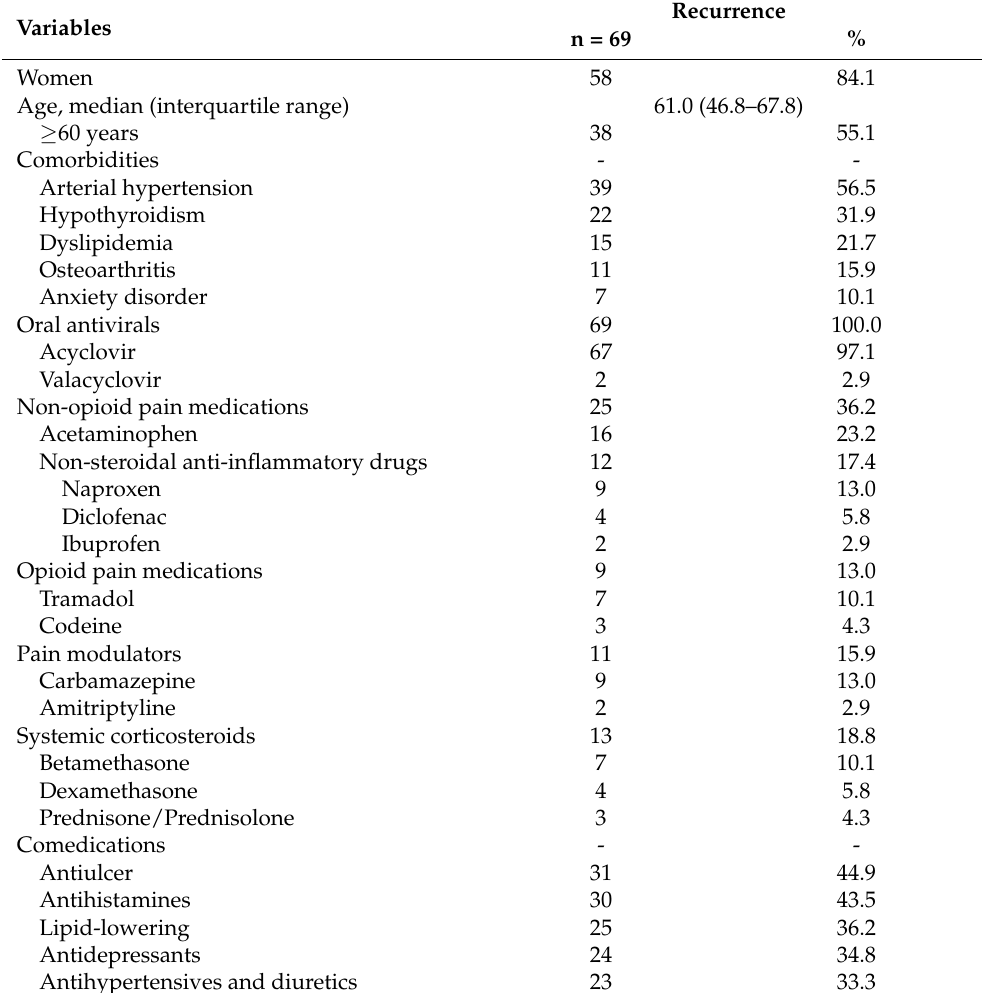
Table 2. Sociodemographic, pharmacological, and comorbidity characteristics of a group of patients with first recurrence of herpes zoster,